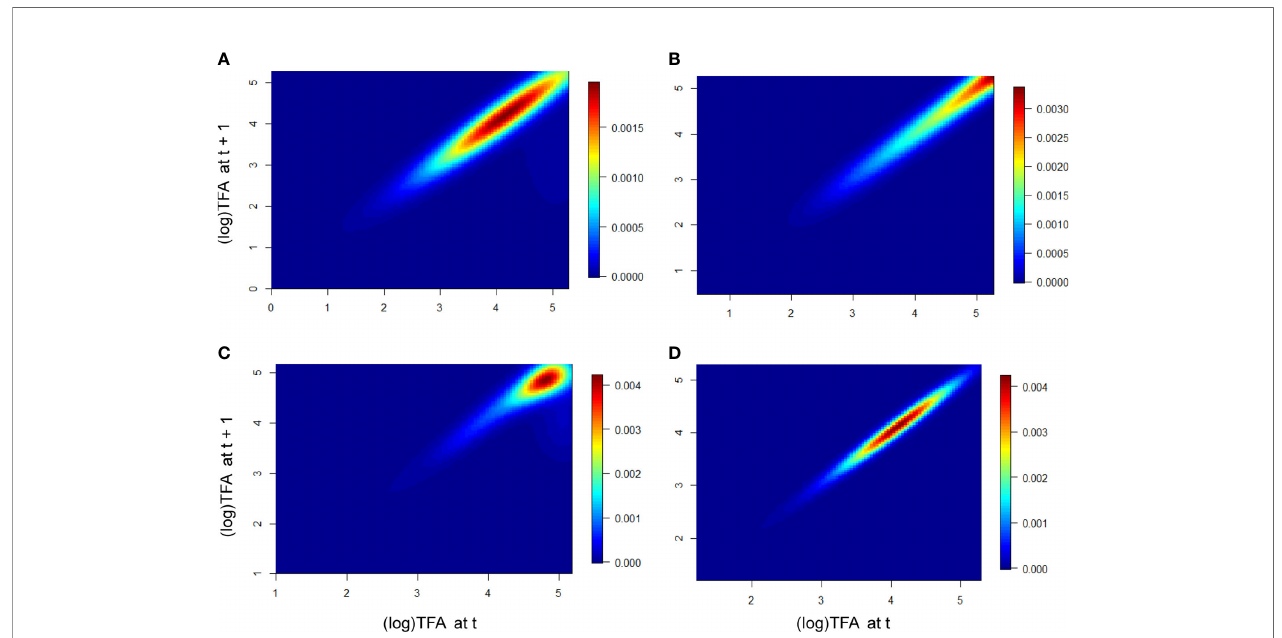
FIGURE 4 | Elasticity of the populations Piedra de Indio and Pino Real. Piedra de Indio (A) fi rst period, (B) second period. Pino Real (C) fi rst period, (D) second period. Warmer colors represent size stages that mostly contributed to l